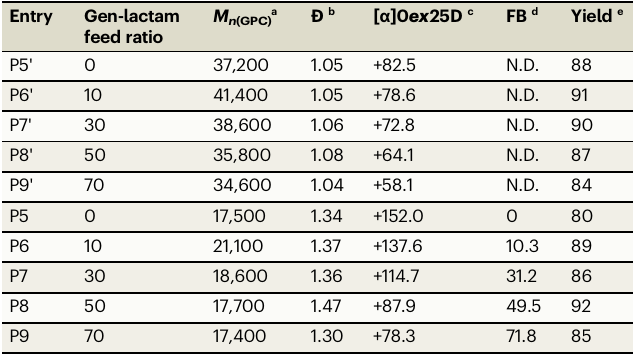
Table 2 | Characterization of PAS copolymers using GPC, NMR, and Optical Rotation Entry Gen-lactam feed